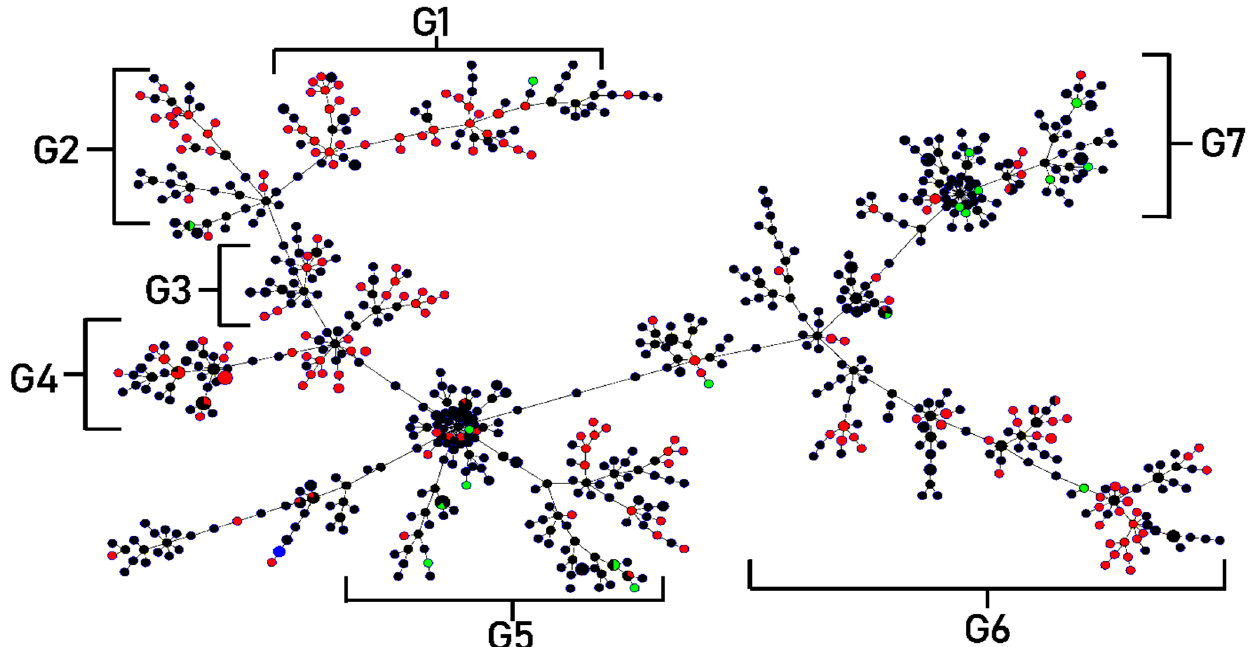
Figure 5. Phylogenetic tree of global S. maltophilia isolates based on MLST allelic profile variation. The minimal spanning tree was created using PHYLOViZ online software with the goeBURST algorithm and the analysis considered 995 isolates reported in the S. maltophilia MLST database. The population distribution of the isolates worldwide is shown. Countries are shown in different colors and STs in each circle . Isolates from Thailand are represented by pink circles and are distributed all around the branches of the tree. Table 5. Genotypic and phenotypic characteristics of S. maltophilia isolates in each clonal complex .